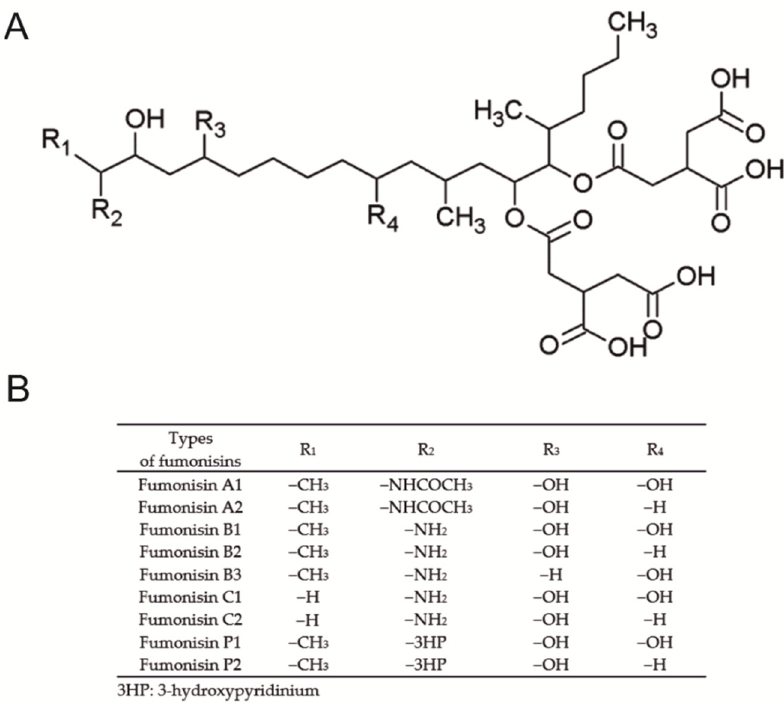
Figure 1. Chemical structure ( A ) and possible analogs of fumonisin ( B ). Type B fumonisins (FB1 and FB2) occur frequently and are very toxic. Both types of FB are an inhibitor of sphingosine N-acyltransferase, but FB2 is a cytotoxic analog of FB1, which is the most abundant and additionally inhibits protein serine/threonine phosphatases [1]. Both FB1 and FB2, which were found in more than 50% of samples of feed and feed raw materials, interfere with sphingolipid metabolism [2,3]. Both types of FB have a similar toxicity and occur naturally in a ratio of FB1 to FB2 of about 3:1 [4]. The presence of FB1 and FB2 in human or animal feed is regulated by EU legislation [5,6]. The development of clinical signs of FB intoxication depends on the dose of FB to which one is exposed. The various clinical implications differ between animal species and are also dependent on the route of FB administration, as well as the sex and age of the animals [7]. Horses, pigs, sheep and rodents are more sensitive to FB compared to other animals and display non-species-specific symptoms, including hepatic or kidney toxicity [8–11], as well as some species-specific symptoms in target organs (such as the brain in horses and the lungs or esophagus in swine) [12]. The bioavailability and toxicity of FBs in ruminants and poultry is poor compared to that of other species. In poultry, morphological and functional changes following FB toxicity are dependent on avian species. Turkeys and ducks are more susceptible to FB toxicity than broiler chickens, in which doses of up to 300 mg/kg feed can induce clinical toxicity [12]. Fumonisin administration, even at a dose of 1.0 mg/kg b.w., leads to degradation of the intestinal barrier [13]. FBs have been shown to be hepatocarcinogenic in rats and mice [14]. They are also potentially hazardous to humans as a causative factor of immunosuppression or neurotoxicity [15,16]. In humans FBs are associated with stunted growth in children, and interference with folic acid uptake and thus are associated with folic acid deficiency-linked birth defects [17,18]. The